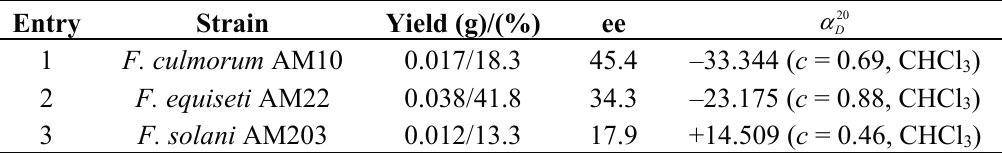
Table 2. Data on hydroxylactone 7a obtained during preparative biotransformations of lactone 3a .